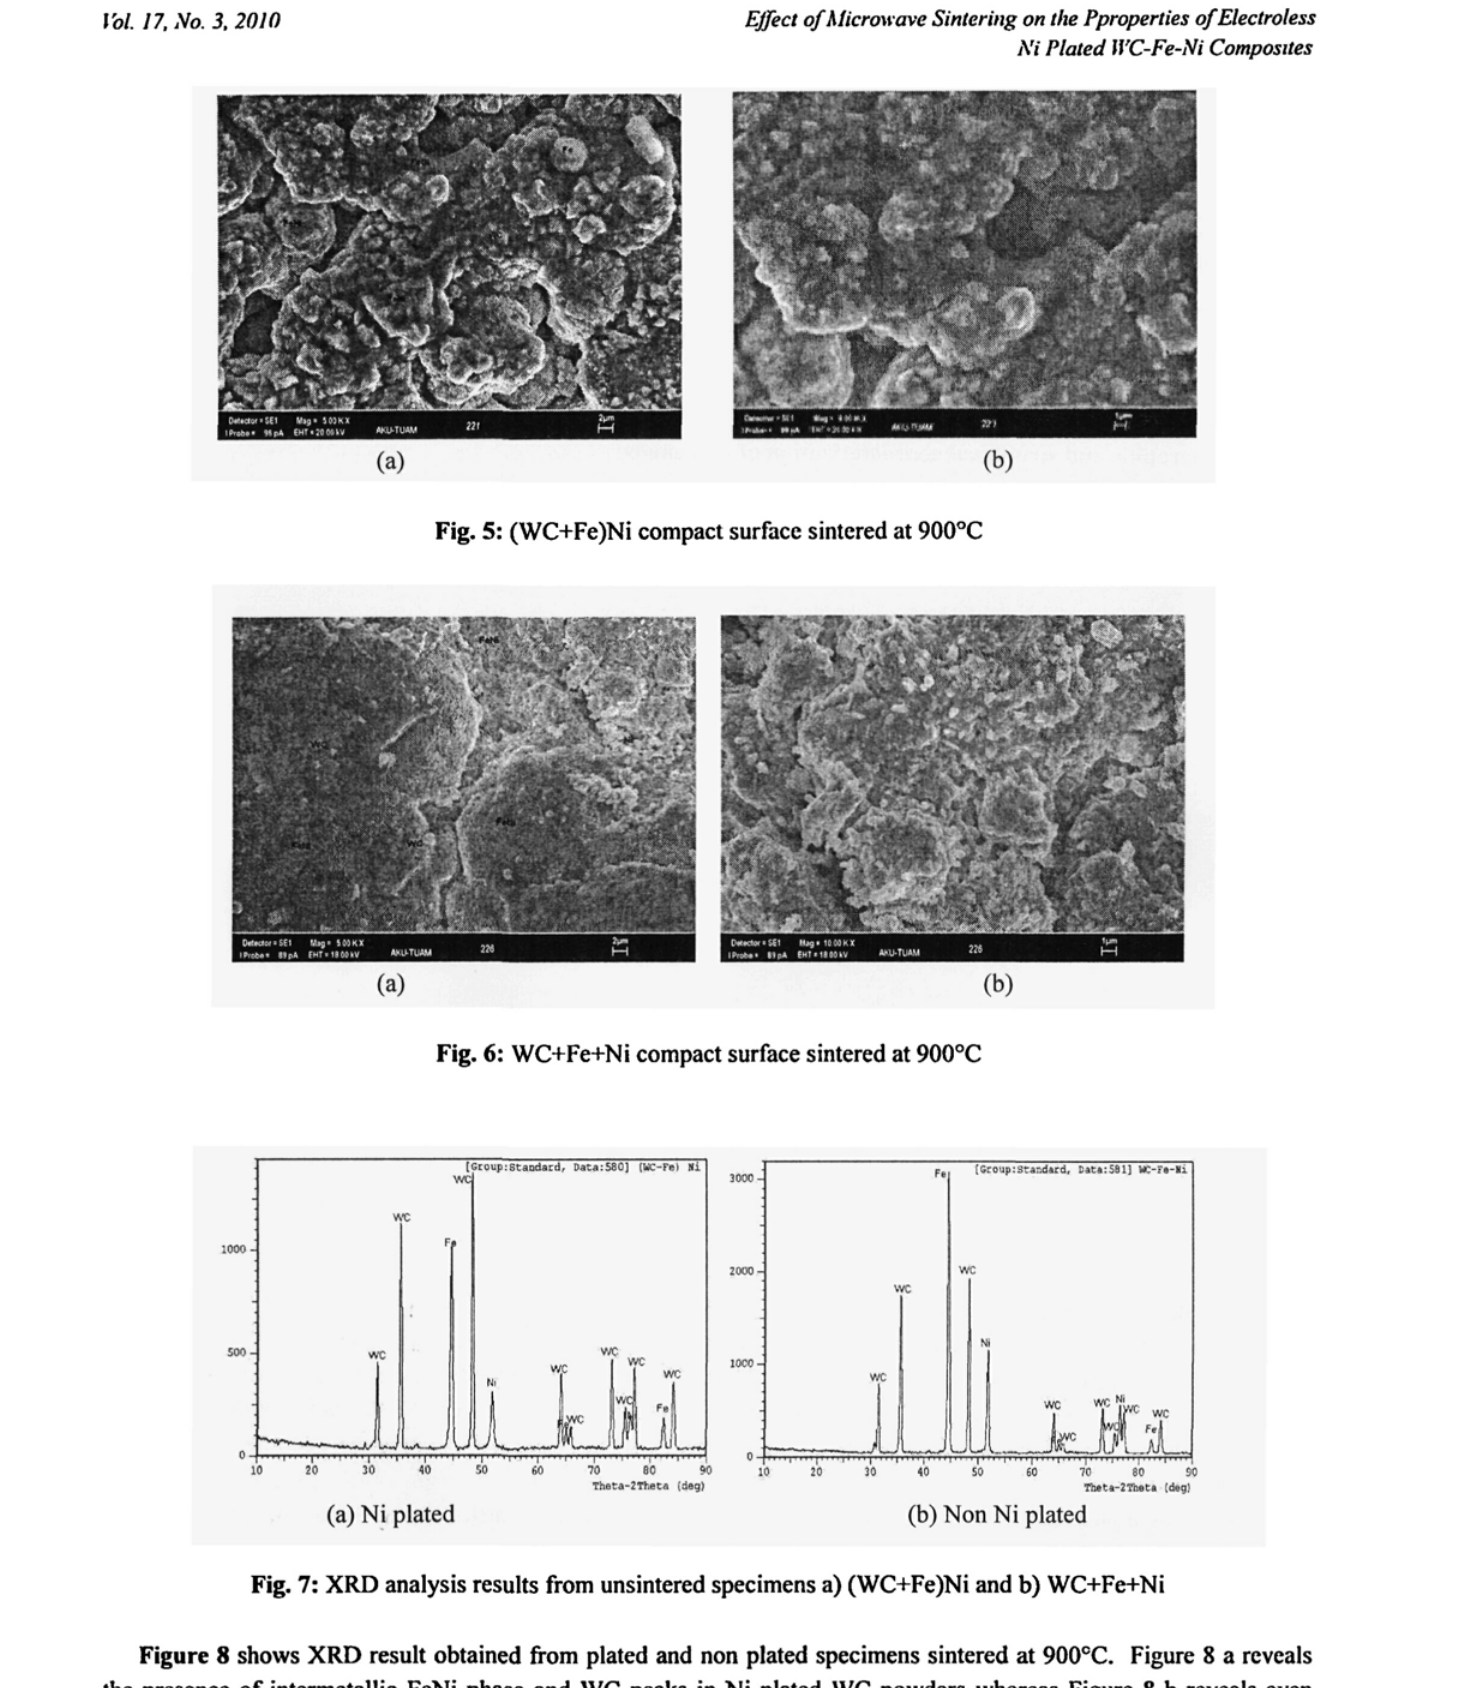
Fig. 7: XRD analysis results from unsintered specimens a) (WC+Fe)Ni and b)